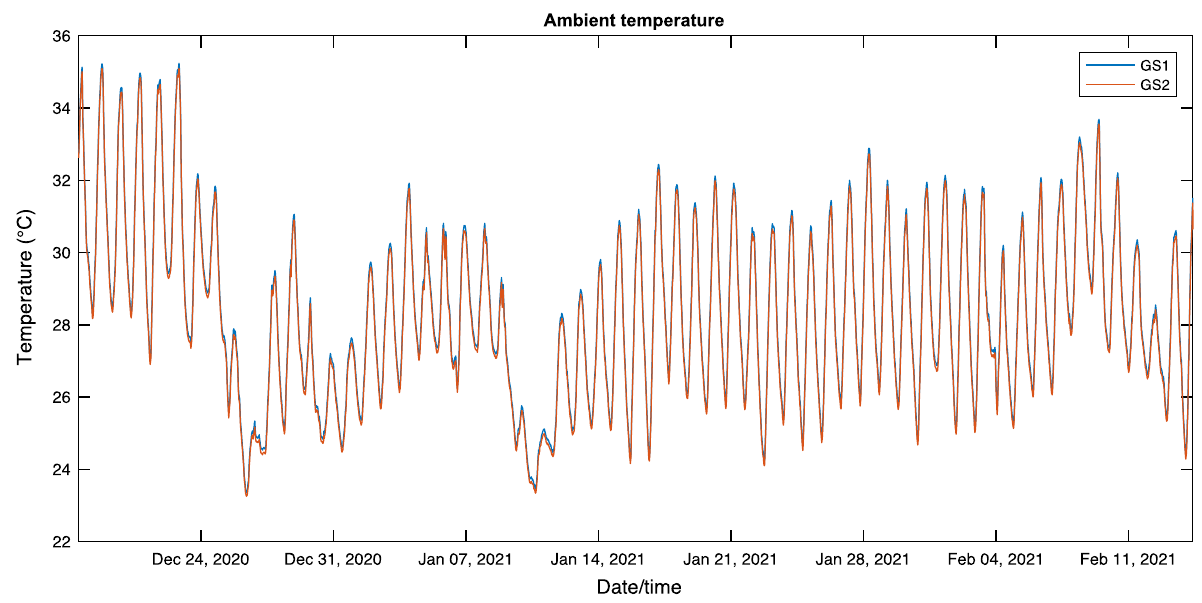
Fig. 8 Ambient temperature as reported by the two gas monitoring stations (GS1 and GS2). Note the cyclical 24 h periodicity due to day-night transition. On average 28.4 ± 2.4 °C for GS1 and 28.2 ± 2.4 °C for GS2